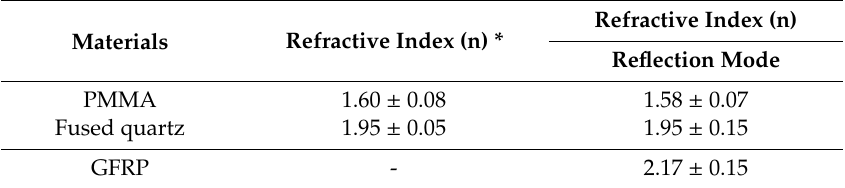
Figure 3. THz time-domain spectroscopy (TDS) pulses from a transmitted PMMA specimen. Table 1. Averaged data on the T-ray “n” values of the materials researched.